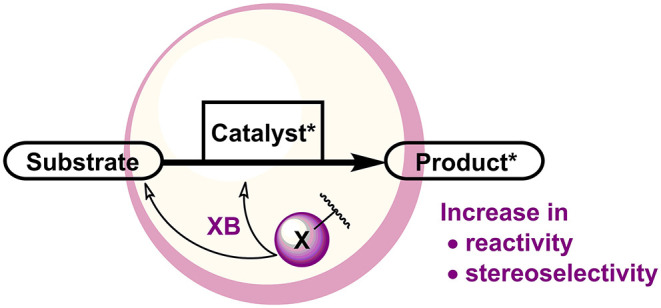
XBs in influencing enantioselective catalytic reactions.